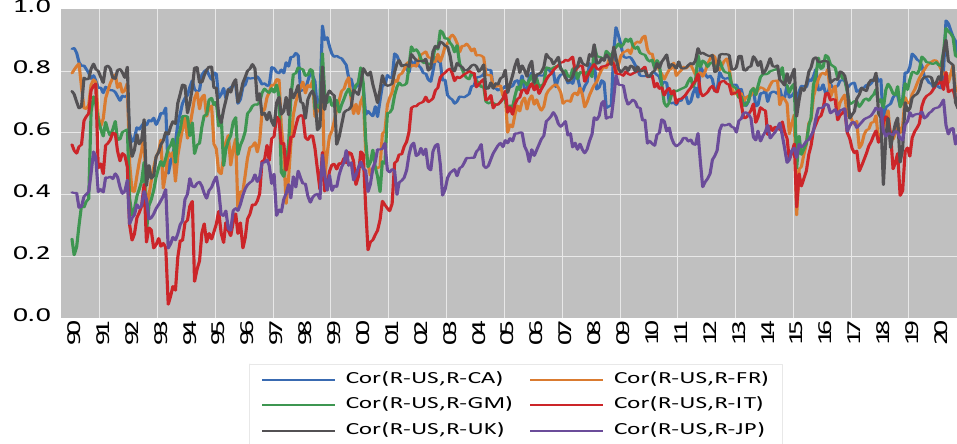
Figure 1. Plots of dynamic correlation coefficients for U.S. and other G7 markets.